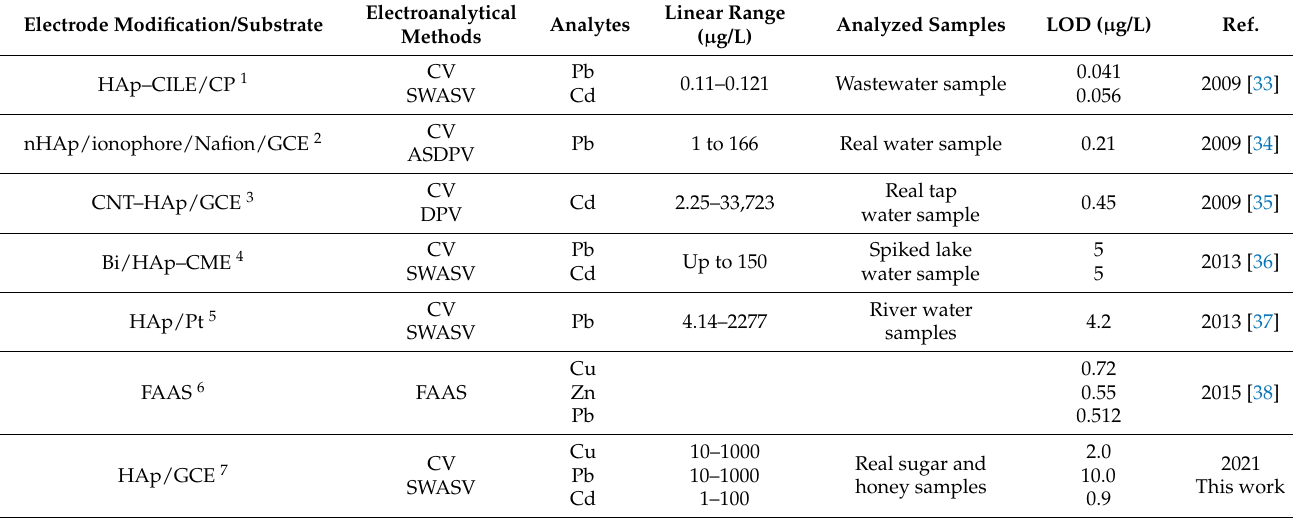
Table 1. Electroanalytical and analytical performances reported for the electrochemical determination of selected heavy metals at the HAp-modified